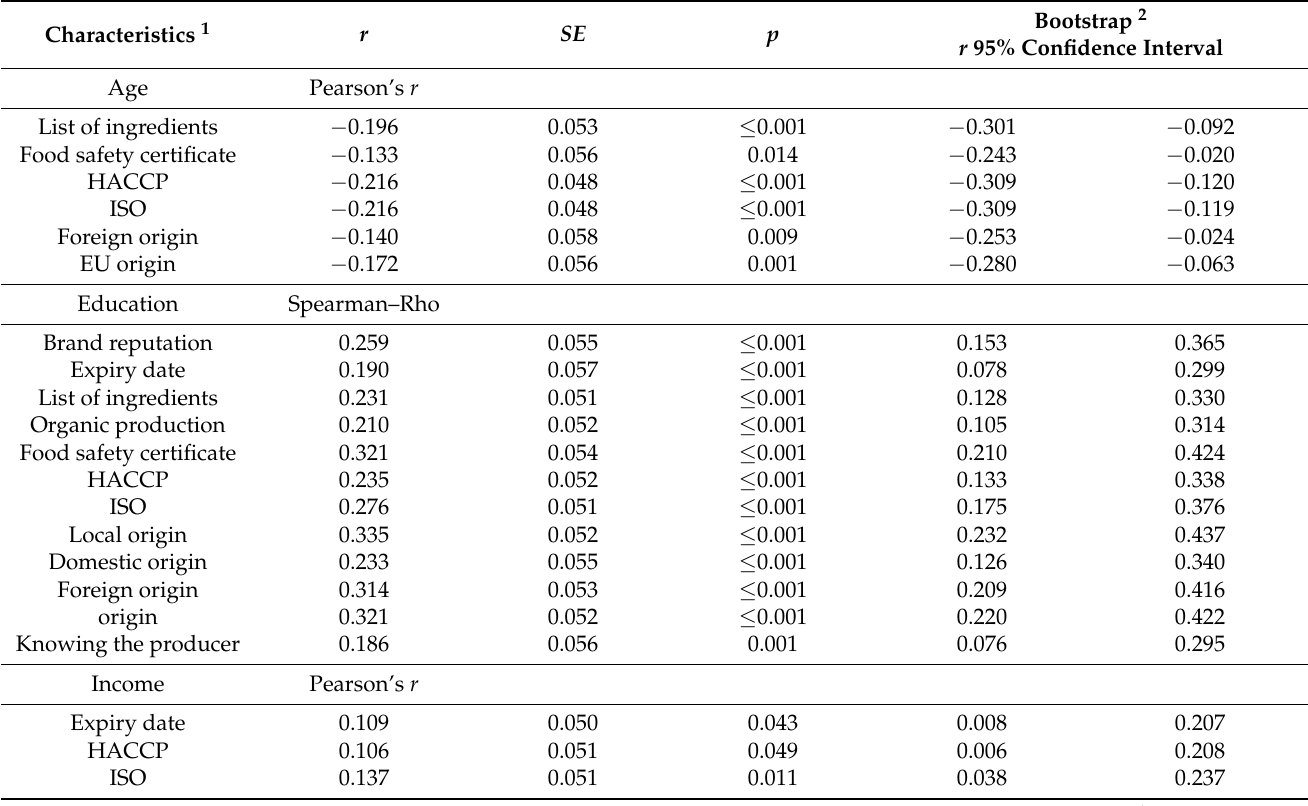
Table A3. Significant correlation coefficients for socio-demographic variables and rating of food safety and quality cues in Albania (Tirana; n = 343); correlation coefficients including bootstrap